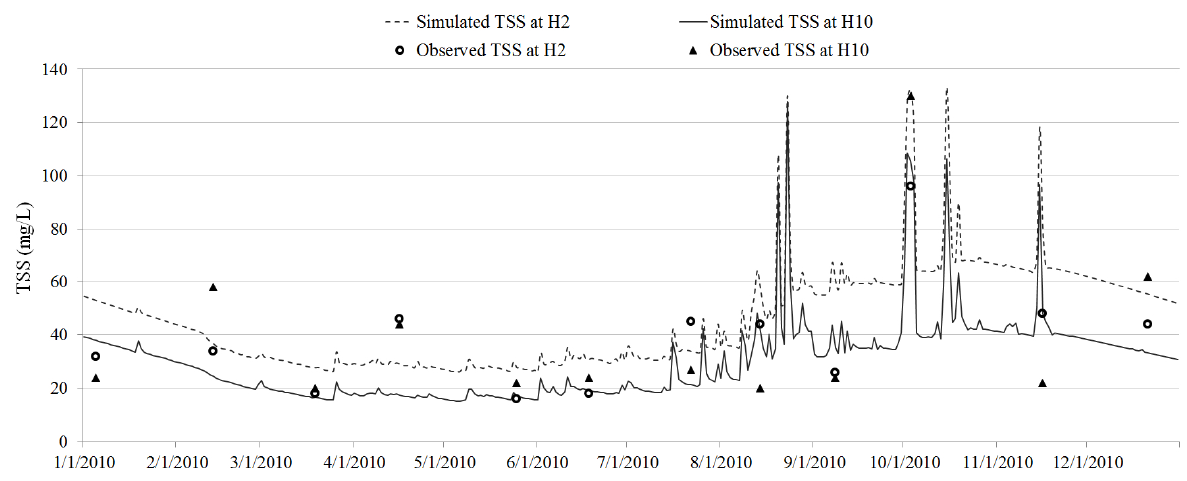
Figure 12. Simulated and observed TSS at H2 and H10 in